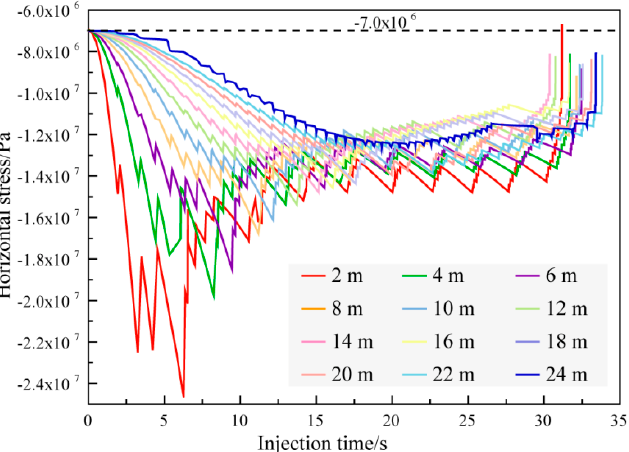
Figure 4. Horizontal stress at two perforation centers. The stress at this position is the in situ stress (7 MPa) before the beginning of fracturing. With the progress of fracturing, the stress first increases and then decreases.